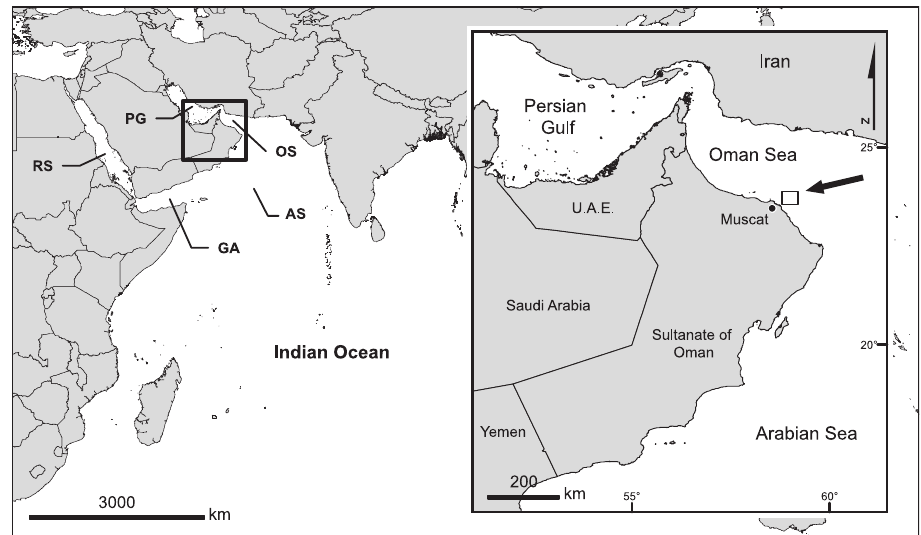
Figure 1. Type locality of Melithaea davidi sp. n. in the Oman Sea, off Muscat governorate. RS = Red Sea, PG = Persian Gulf, GA = Gulf of Aden, OS = Oman Sea, AS = Arabian